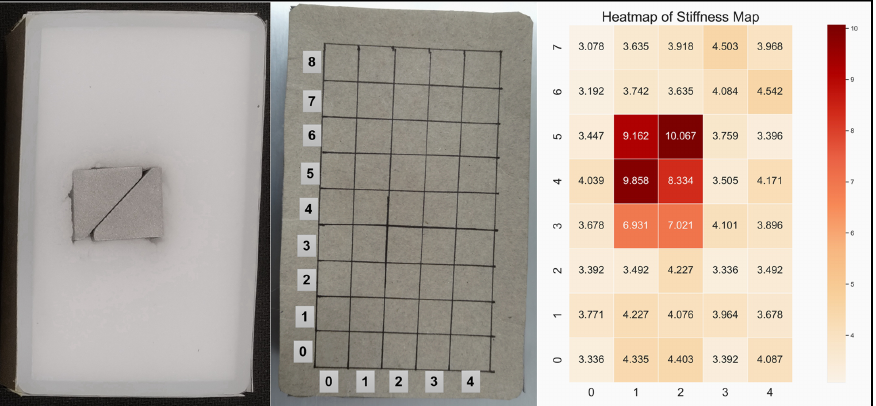
Figure 10. Picture on the left is the inner view of the object-*, picture in the middle shows the grids drew on its surface. The picture on the right shows the stiffness map of object-* represented with a heat-map. The values inside the picture are the stiffness at each location. During the test, the grids of 0–4 and 0–7 (vertical) were compressed. Compared with the left picture, it can be seen that the robot was able to locate the stiff object inside the sponge through haptic exploration and a vision